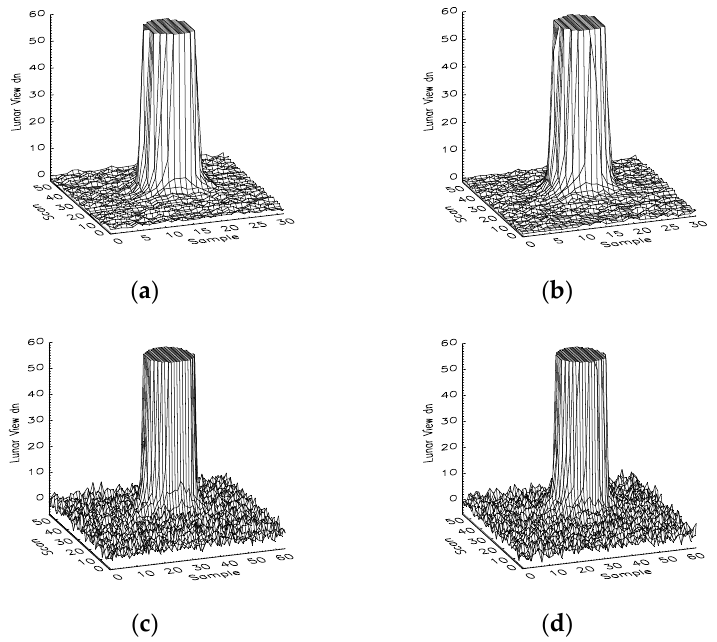
Figure 6. Lunar images observed by SNPP VIIRS thermal emissive bands M12 and I4 on 2 April 2012: ( a ) Band M12 Detector 8, ( b ) Band M12 Detector 9, ( c ) Band I4 Detector 16, and ( d ) Band I4 Detector 17.